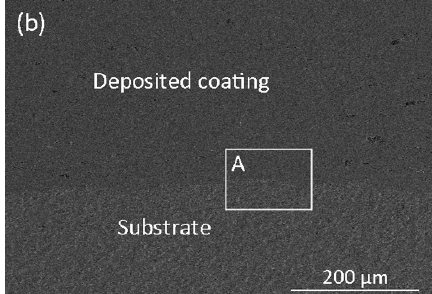
Figure 3. Cross-sectional morphology of the Ti6Al4V deposited coating: ( a ) general view; and ( b ) the interface.